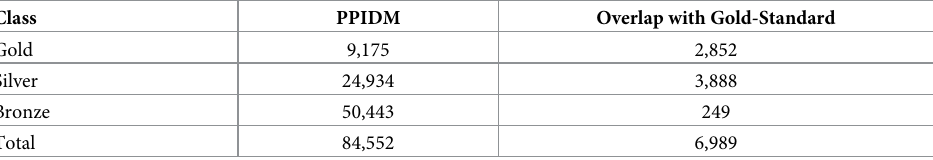
Table 3. The distribution in Gold , Silver and Bronze categories of all DDIs inferred by PPIDM, and of their over- lap with our Gold-Standard.